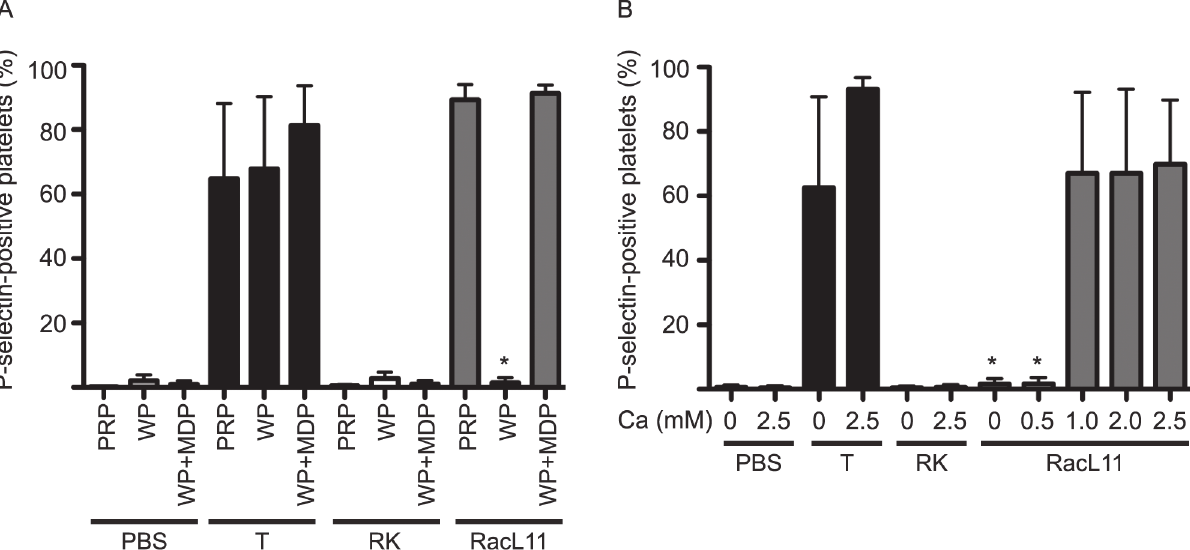
Fig 4. EHV-1-induced platelet P-selectin expression requires plasma and exogenous calcium. A : Effect of plasma: Equine platelets in ACD- anticoagulated platelet-rich plasma (PRP), washed platelets (WP) or washed platelets with added ACD-anticoagulated platelet-derived microparticle- depleted plasma (WP+MDP) were exposed for 10 minutes to RacL11 at 1 PFU/cell with PBS and RK lysate negative controls and a thrombin (T, 0.15 U/mL) positive control. Washed platelets did not express P-selectin when exposed to virus unless plasma was present. In contrast, thrombin-induced P-selectin expression was independent of plasma (n = 5). Data represents mean ± SD. * p < 0.001 versus PRP or WP + MDP for RacL11-exposed platelets. B : Effect of calcium: Equine citrate-anticoagulated PRP was exposed to RacL11 at 1 PFU/cell for 10 minutes with increasing calcium concentrations (0 to 2.5 mM), with the above controls. EHV-1-induced P-selectin expression required at least 1 mM of exogenous calcium (n = 3). Data represents mean ± SD. * p < 0.001 versus 1.0, 2.0 or 2.5 mM calcium.